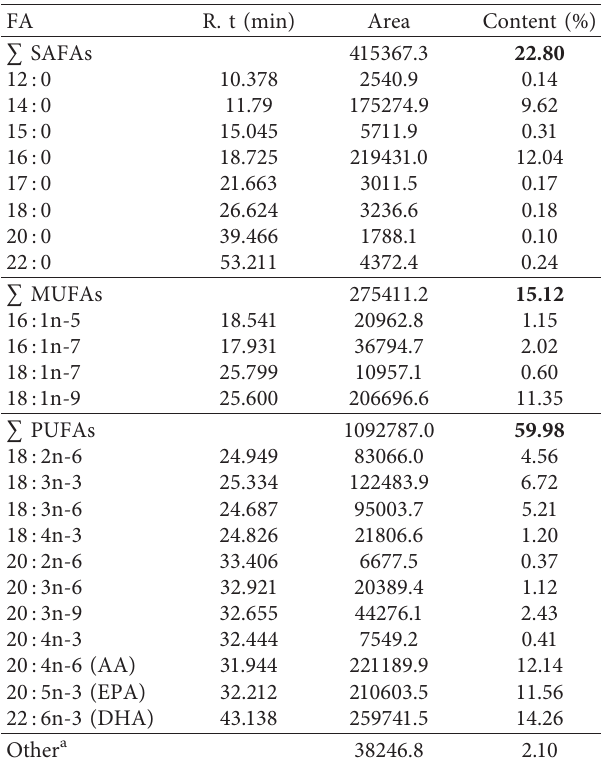
Table 2: Fatty acid profile (% of total) is identified by GC through the retention time, presented with relative abundance (%) through the area of peaks.